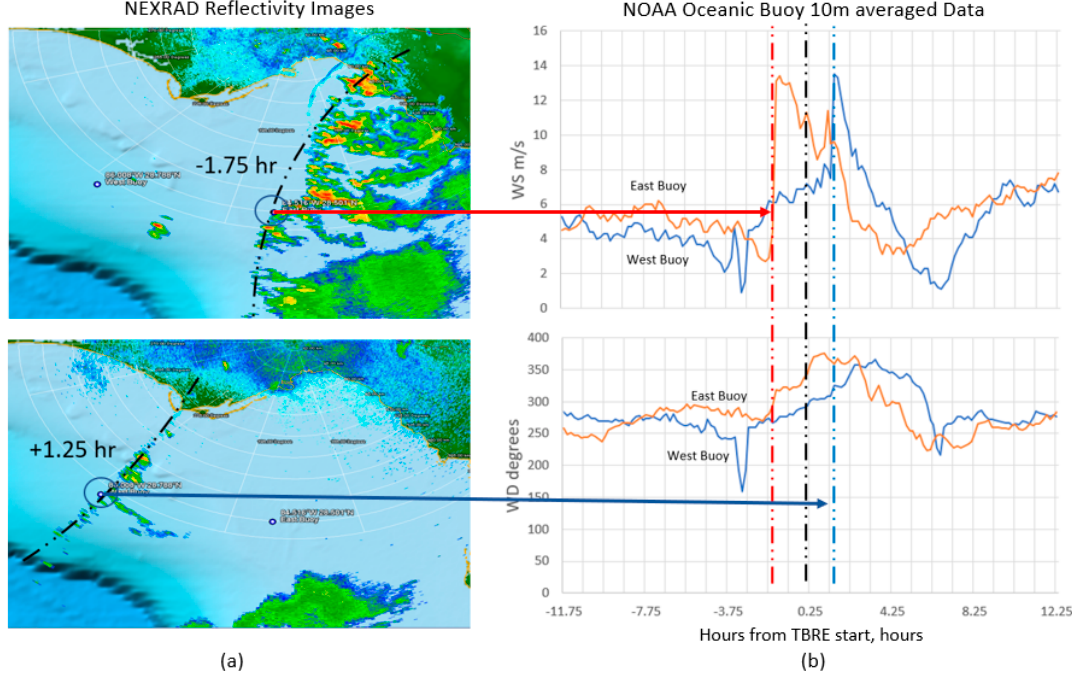
Figure 6. Ocean buoy anemometer timeseries during the TBRE. Panel ( a ) shows the NEXRAD reflectivity image as the atmospheric front passes over the East buoy (top) and West buoy (bottom), and Panel ( b ) shows the anemometer timeseries of WS and WD from the East (orange) and West (blue) buoys, where the x axis is the relative time since the start of TBRE. The vertical red and blue lines indicate the times when the atmospheric front passes over the East ( − 1.75 h) and West buoy (+1.25 h), respectively, and the middle (black) line indicates the time (0:00 h) of the GH overflight. As previously mentioned, the aerial extent of HIWRAP wind measurements was rel-